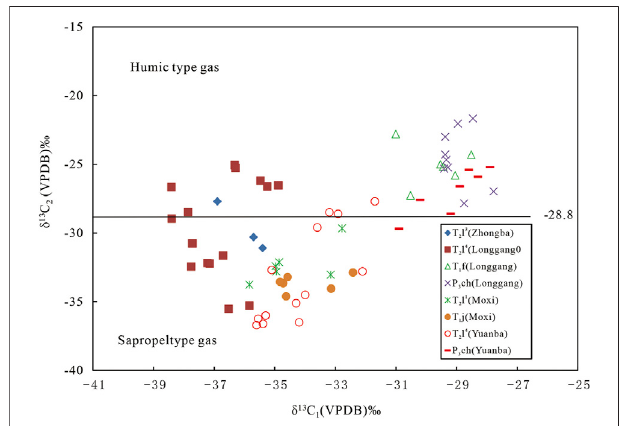
FIGURE 6 | Comparison of δ 13 C 1 and δ 13 C 2 in natural gas between the Leikoupo Formation and underlying gas